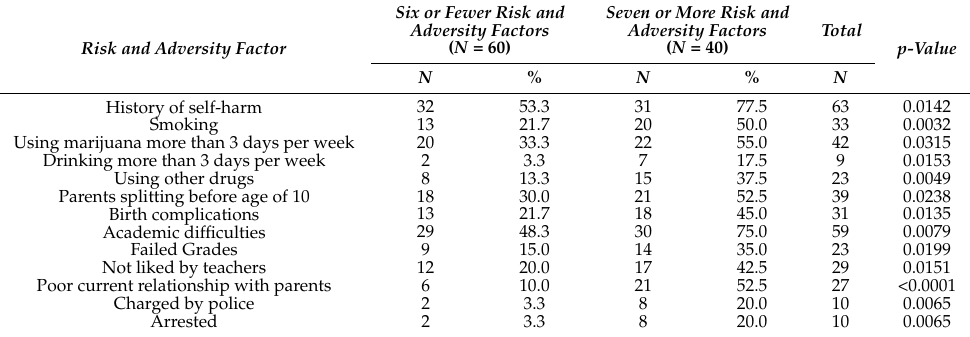
Table 4. Association of type of risk and adversity factor as compared to the number of risk and adversity